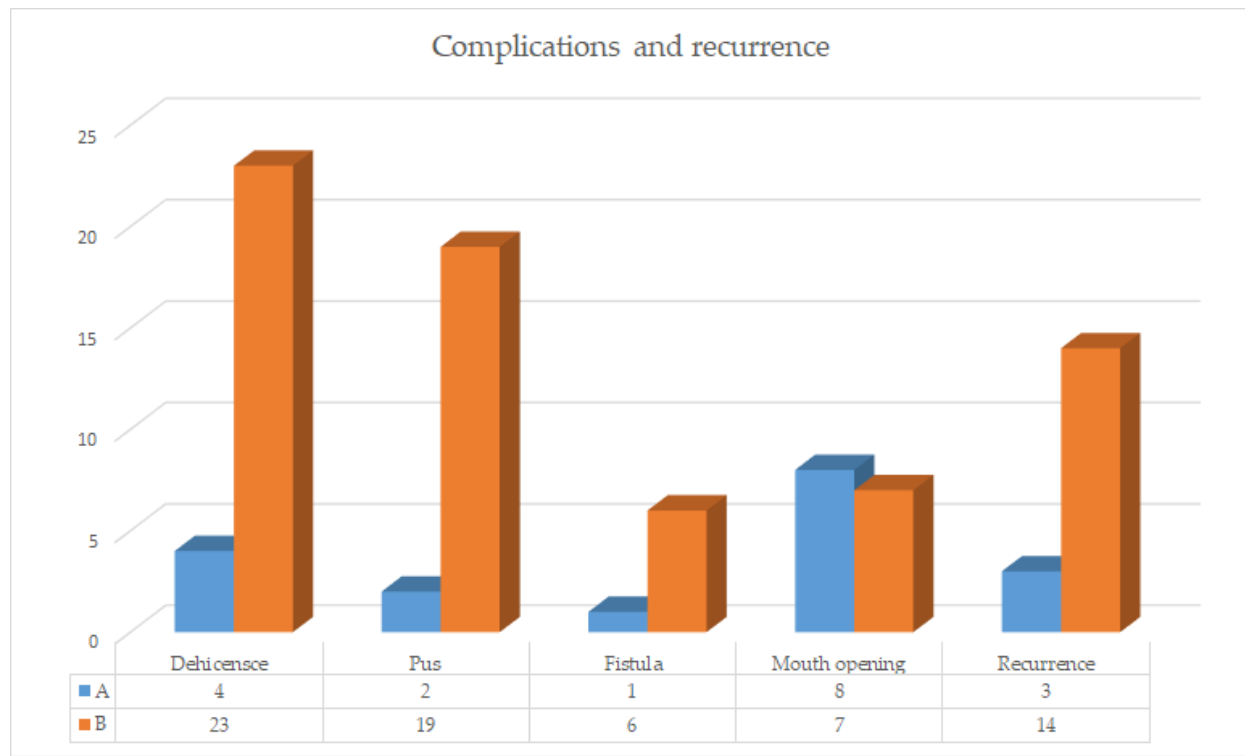
Figure 5. Complication and recurrence histograms group A vs. group B.